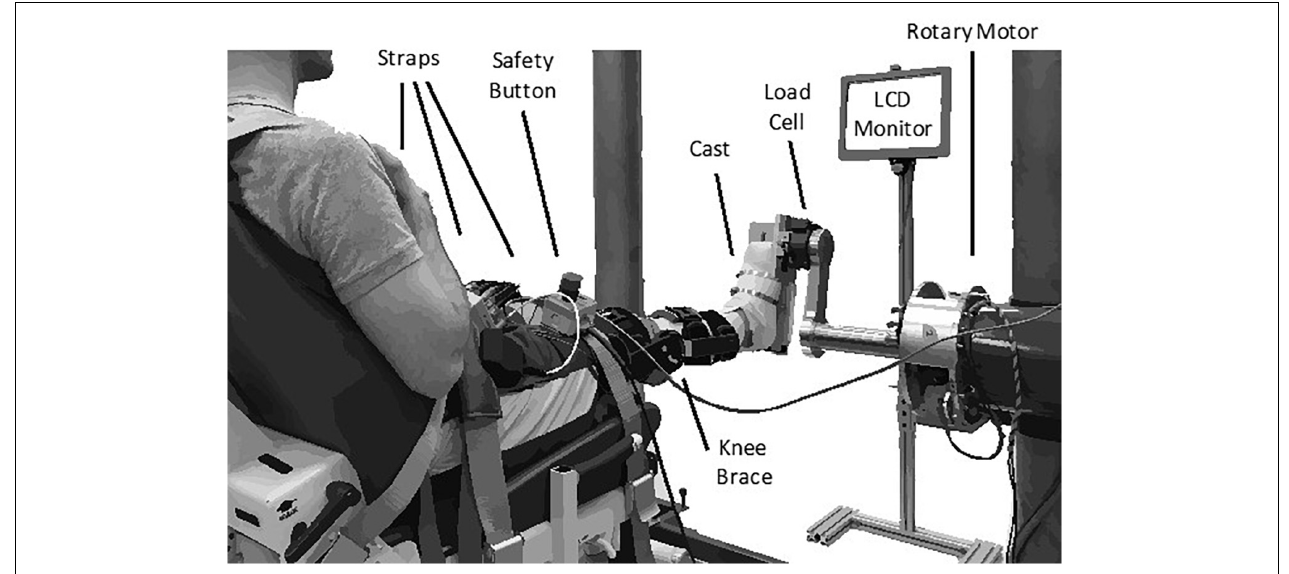
FIGURE 1 | Experimental